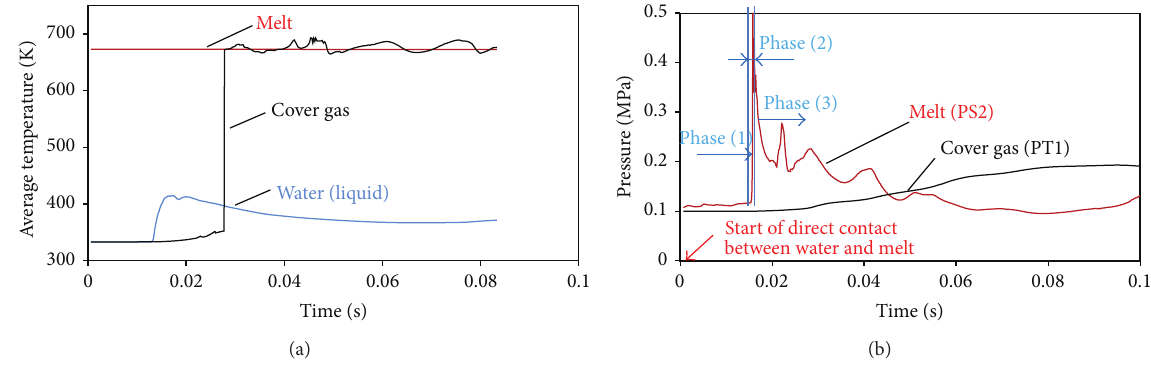
Figure 8: Temperature and pressure history for calculated Run